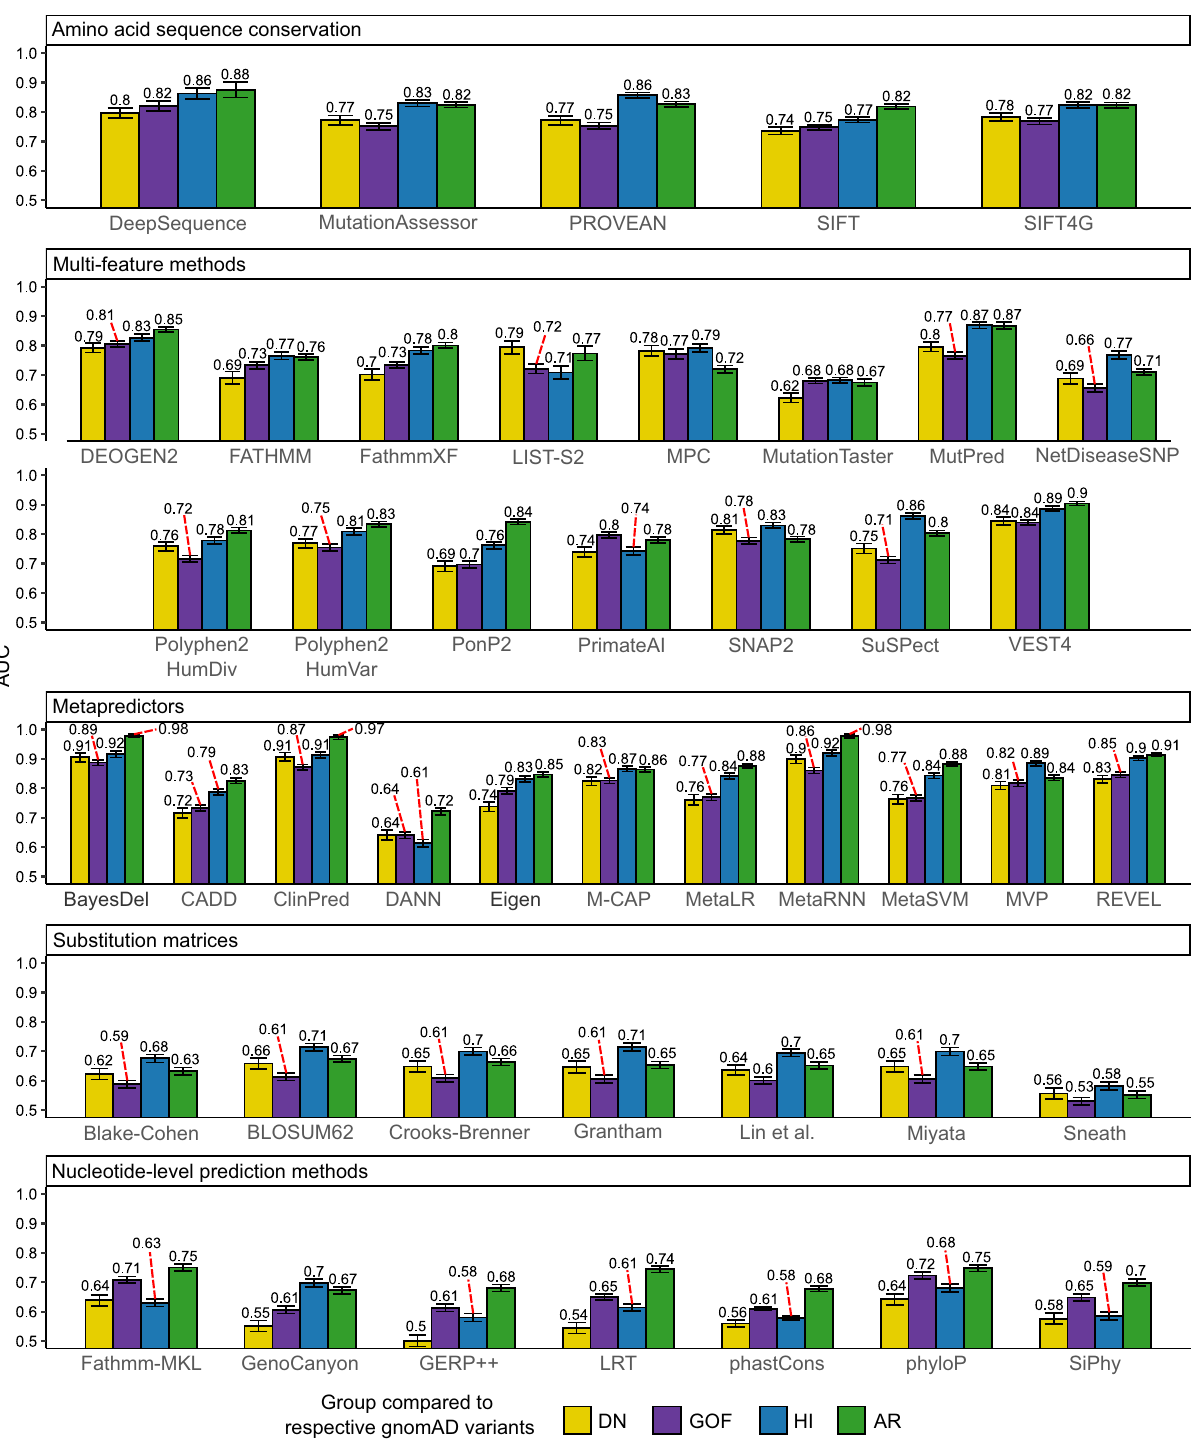
Fig. 5 Dominant-negative and gain-of-function mutations are less well identi fi ed by nearly all computational variant effect predictors than loss-of- function mutations. AUC values calculated from ROC curves for discriminating between different types of pathogenic ClinVar mutations and putatively benign gnomAD variants, using the outputs of different computational variant effect predictors. Only homozygous gnomAD variants were included for the AR analysis. Error bars denote 95% con fi dence intervals. Source data are provided as a Source Data fi